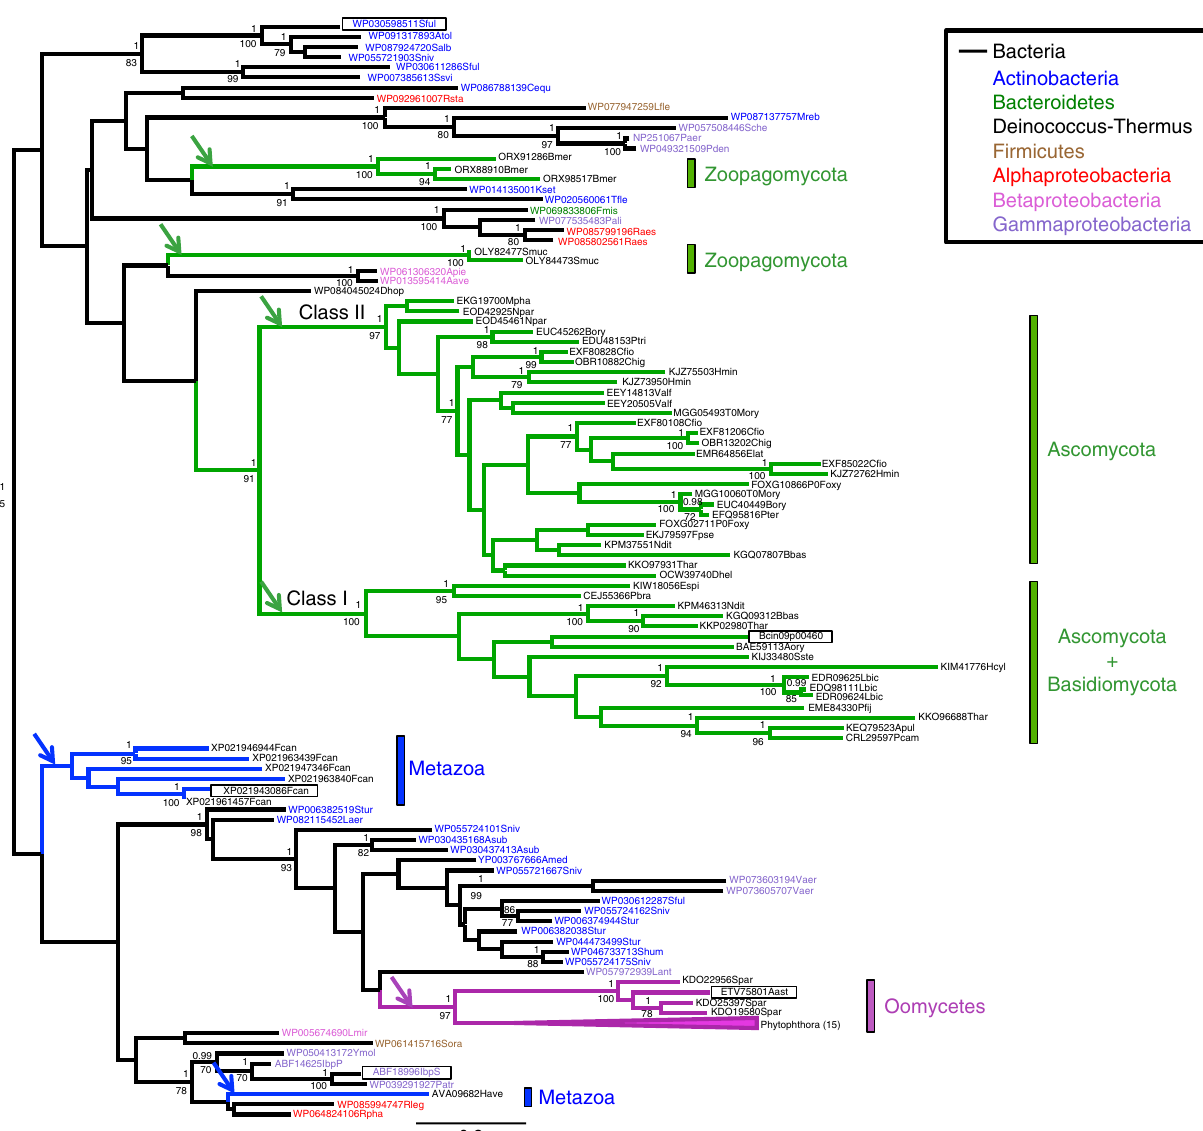
Fig. 1 Phylogeny of IbpS and homologs. An alignment of 198 amino acids from 122 sequences was used to construct the phylogenies. The maximum likelihood tree was used as a reference topology. Bootstraps of interest ≥ 70 are shown below the branches and the corresponding posterior probabilities in the Bayesian topology are reported above. Arrows represent probable transfer events from bacteria to eukaryotes. The names of the proteins analyzed in this study are indicated in bold. The structure-based sequence alignment of the proteins with a boxed name is shown in Supplementary Fig. 8. The branches leading to fungal proteins are colored green, those leading to oomycete proteins are colored in red and those leading to metazoan proteins are colored in blue. The bacterial protein names are colored as described in the box. The corresponding species and sequence accession numbers are available in Supplementary Data